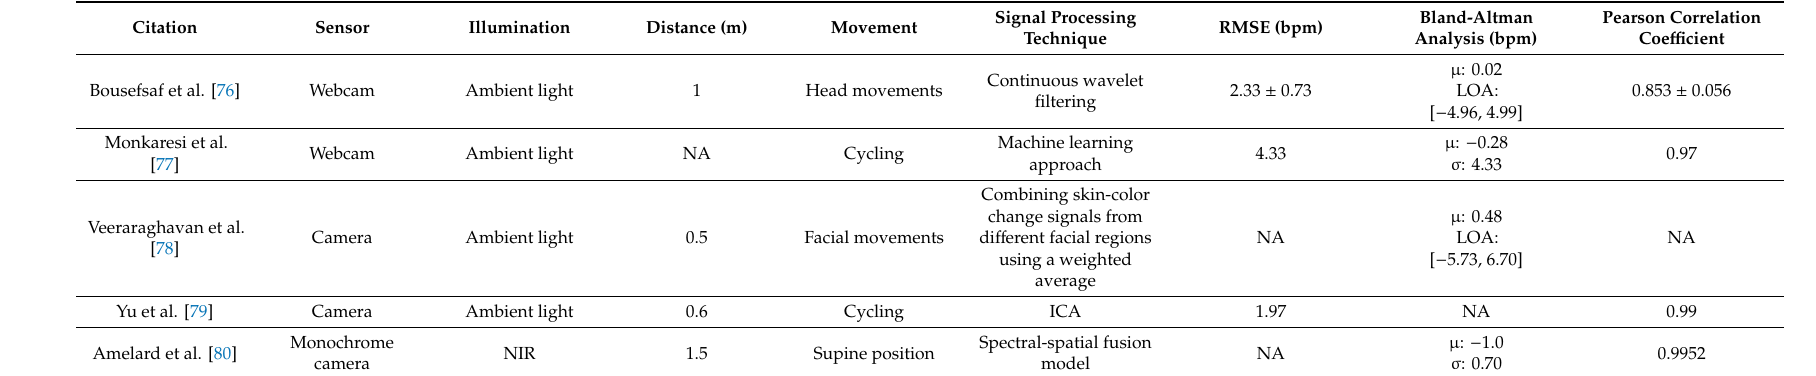
Table 7. Summary of PPGI techniques for HR monitoring, part